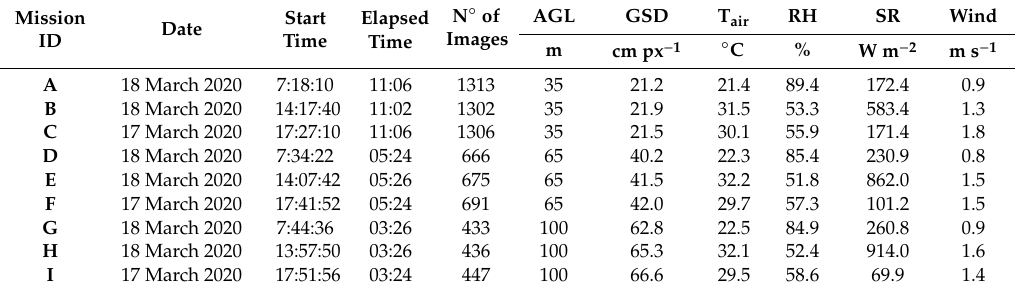
Table 2. Flight mission details. AGL = Above Ground Level; GSD = Ground Sample Distance; T air = Air temperature; RH = Relative humidity; SR = Shortwave